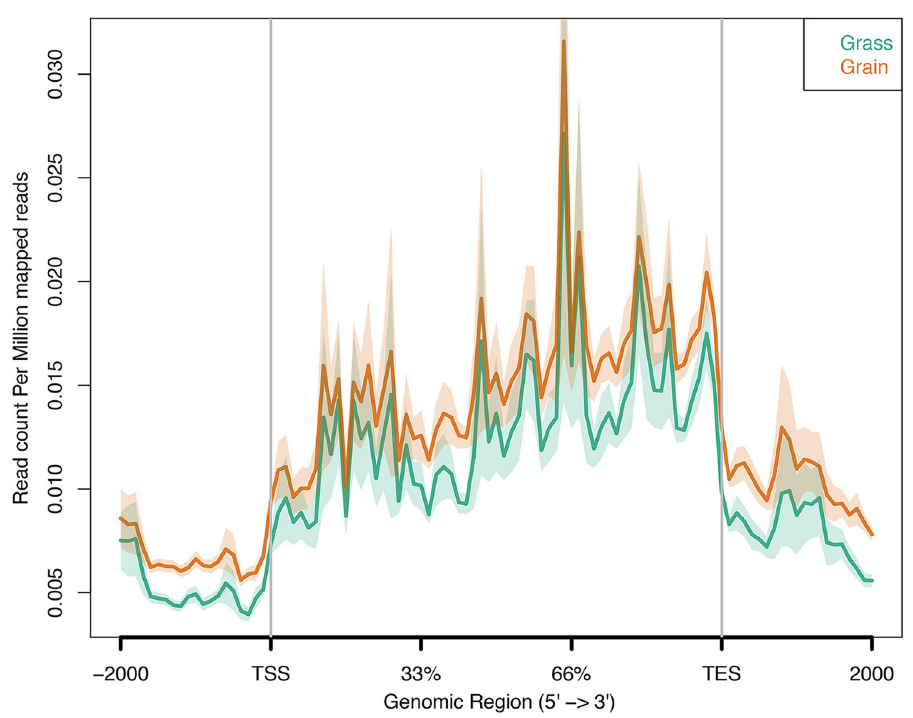
Fig 6. DNA methylation patterns around gene bodies in grass-fed and grain-fed animals measured by MBD-Seq. The x axis indicates the position around gene bodies, and the y axis indicates the normalized read number aligned to the normalized gene body region and the around